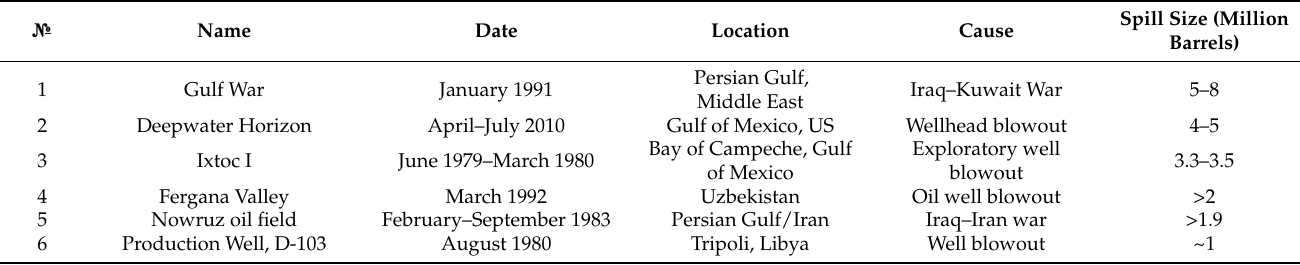
Table 2. Oil spills greater than one million barrels since 1980 caused by offshore exploration and production